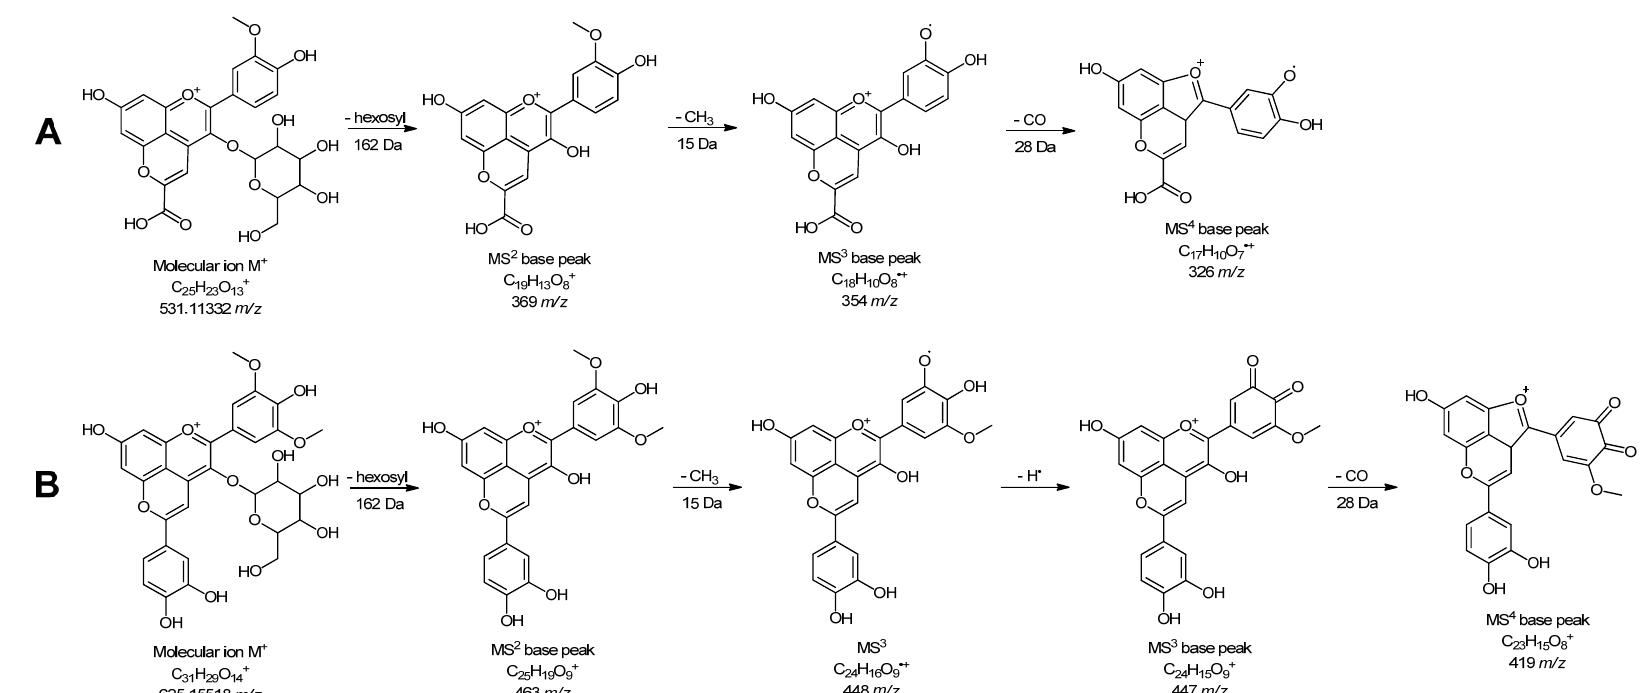
Figure 2. Fragmentation pathway of ( A ) peonidin 3- O -hexoside-pyruvate ( 4’ ) and ( B ) malvidin 3- O -hexoside-4-vinylcatechol ( 24’ ) in positive ionization mode.